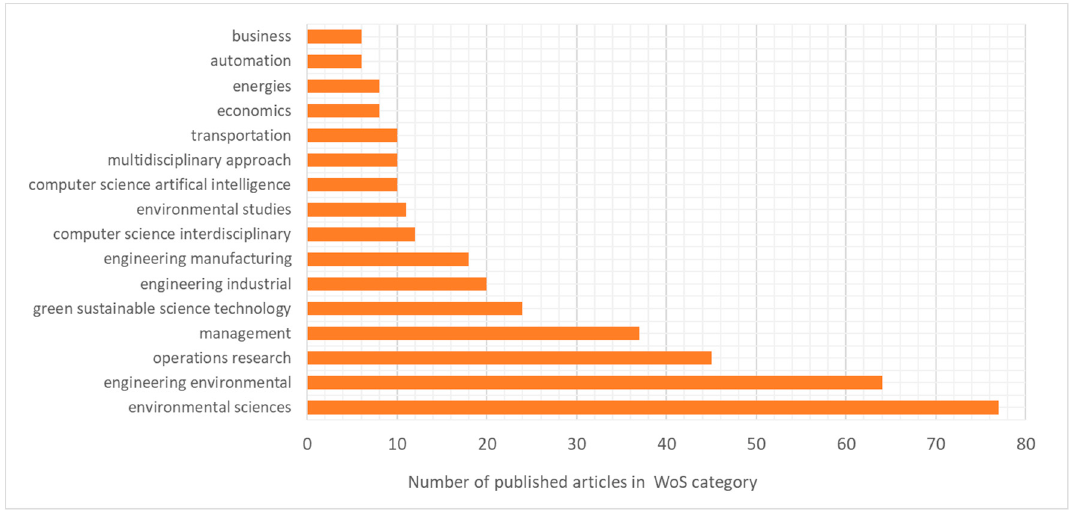
Figure 7. Distribution of papers according to Web of Science categories.